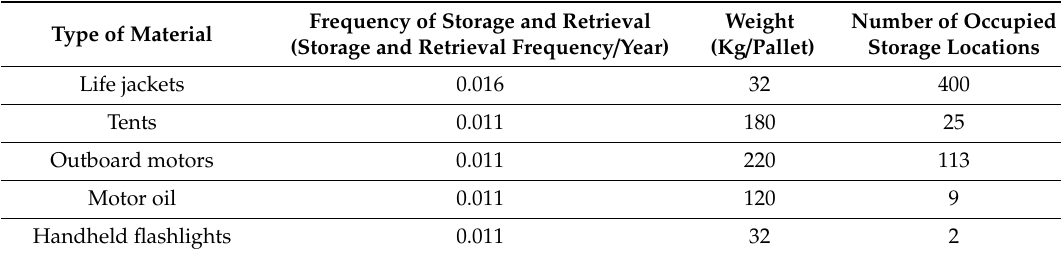
Table 6. Material